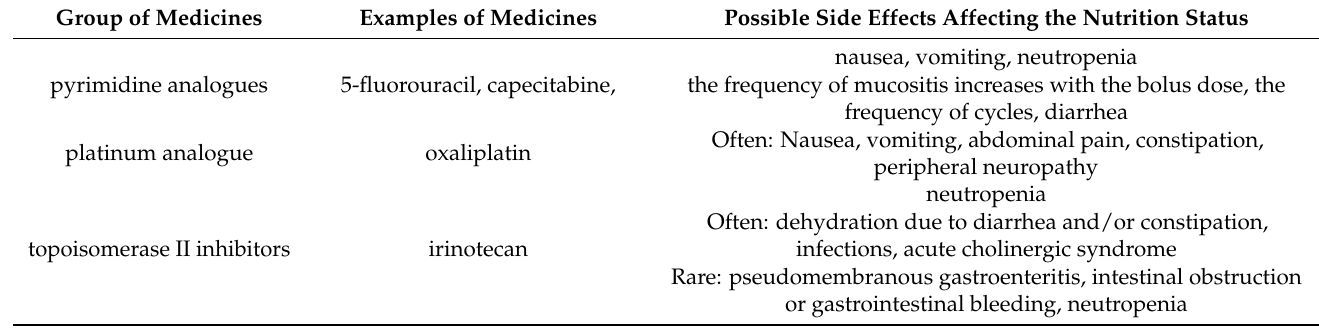
Table 1. Side effects of chemotherapeutics with negative effects on the nutrition status [20–23].